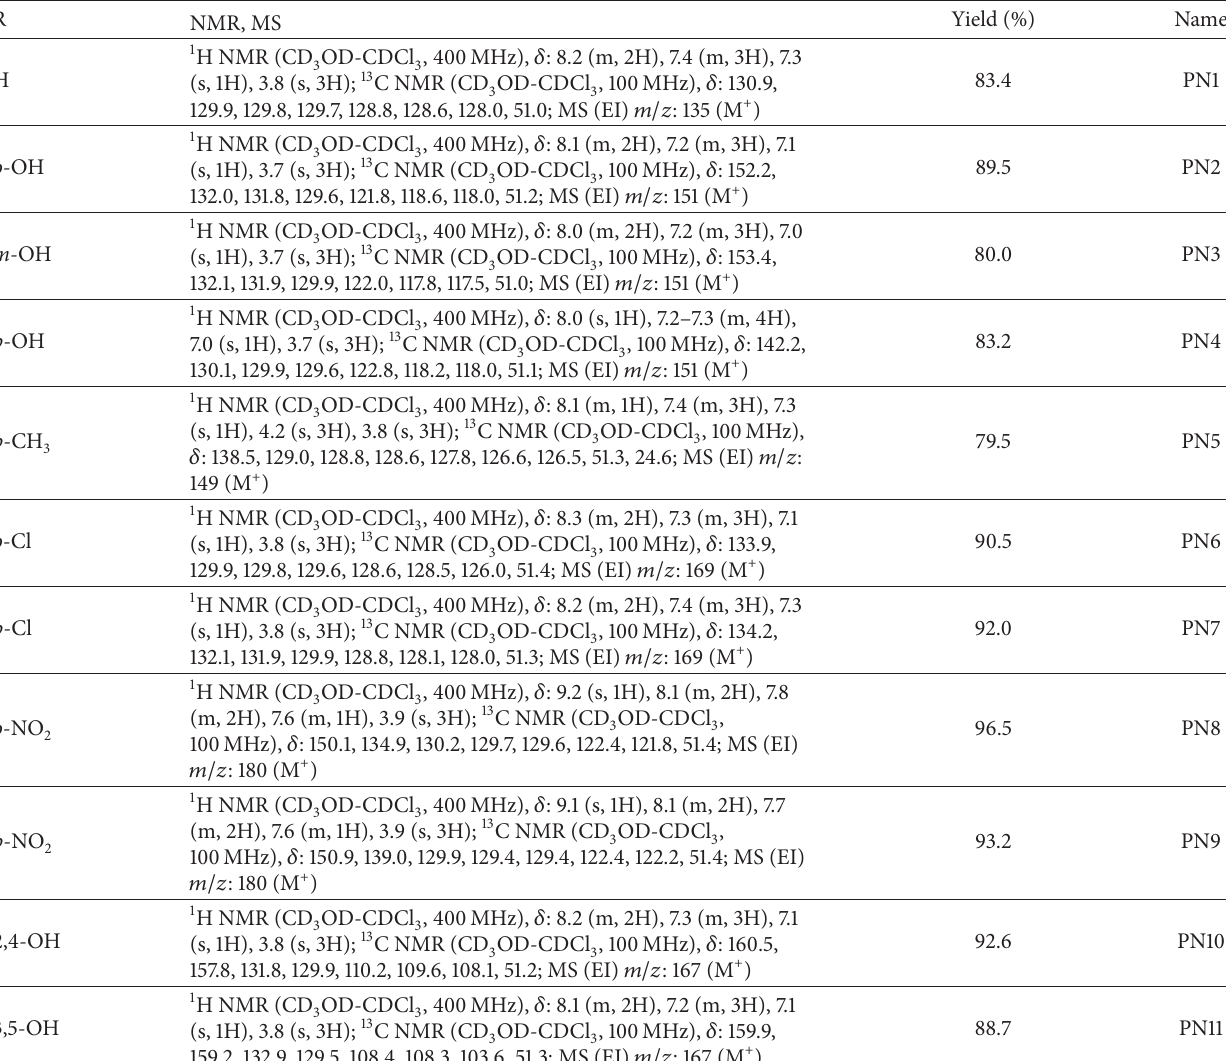
Table 1: The yield, NMR, and MS of phenyl nitrone derivatives.